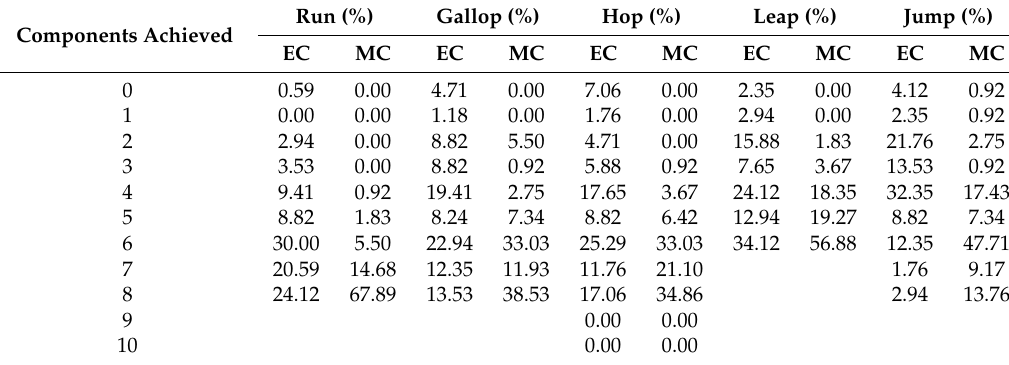
Table 2. Component achievement (%) of locomotor skills during early-childhood (EC) and middle- childhood (MC).